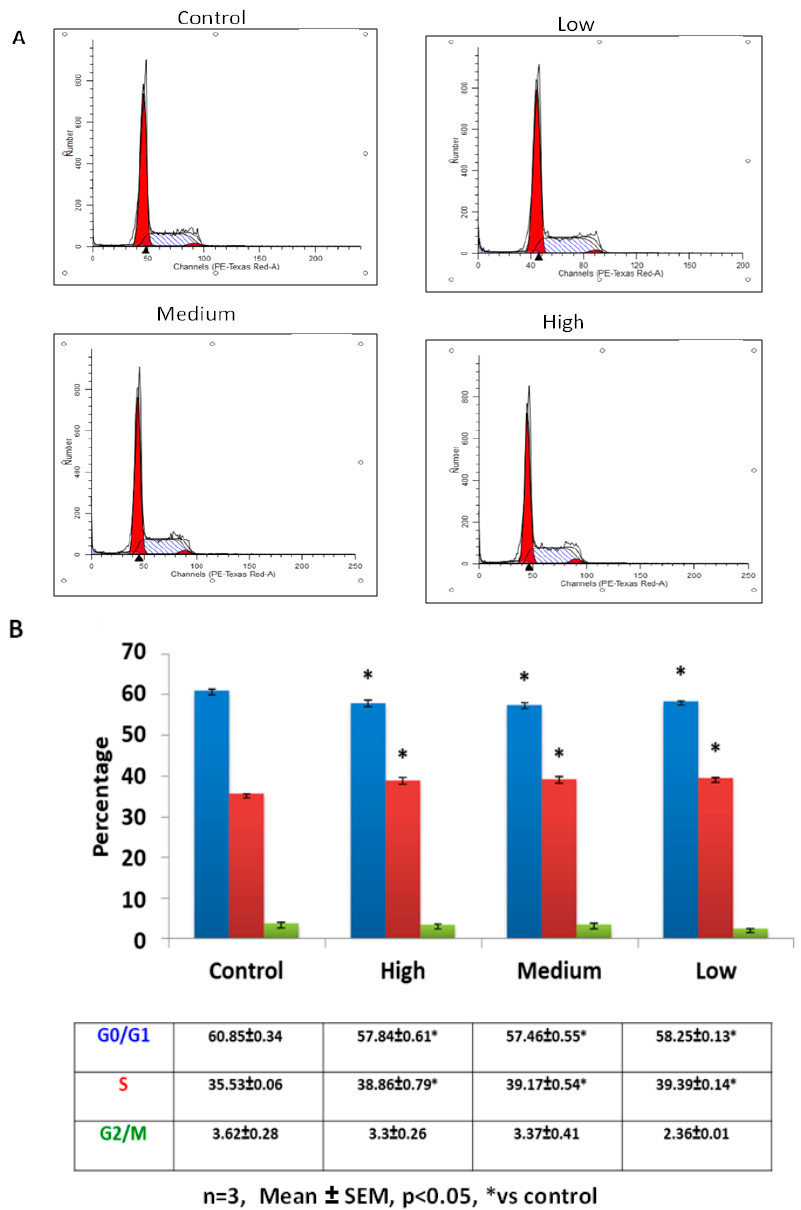
Figure 3. Effect of low, medium and high IL-6 concentration on C2C12 cell cycling after 48 h of treatment. ( A ) Flow cytometric analysis of IL-6-treated cells to determine the effect of low, medium and high IL-6 concentrations on C2C12 cell cycling was done after 48 h incubation ( B ) C2C12 cells (%) in each cell cycle stage after treatment of cells with low, medium and high IL-6 concentrations for 48 h. The experiment was repeated three times. Results are presented as mean ± standard error of the mean (S.E.M). Statistical analysis: ANOVA and Bonferroni post hoc test. * p < 0.05; relative to control.